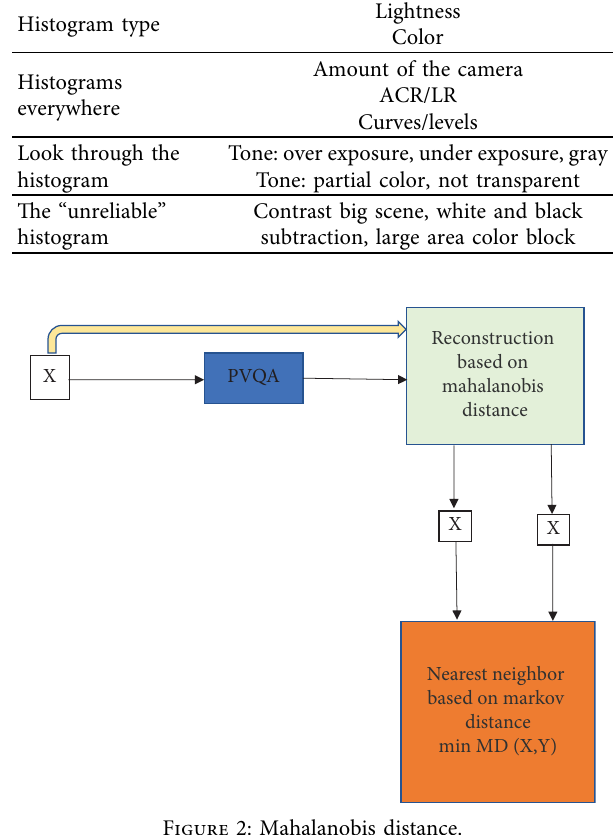
Figure 2: Mahalanobis distance.